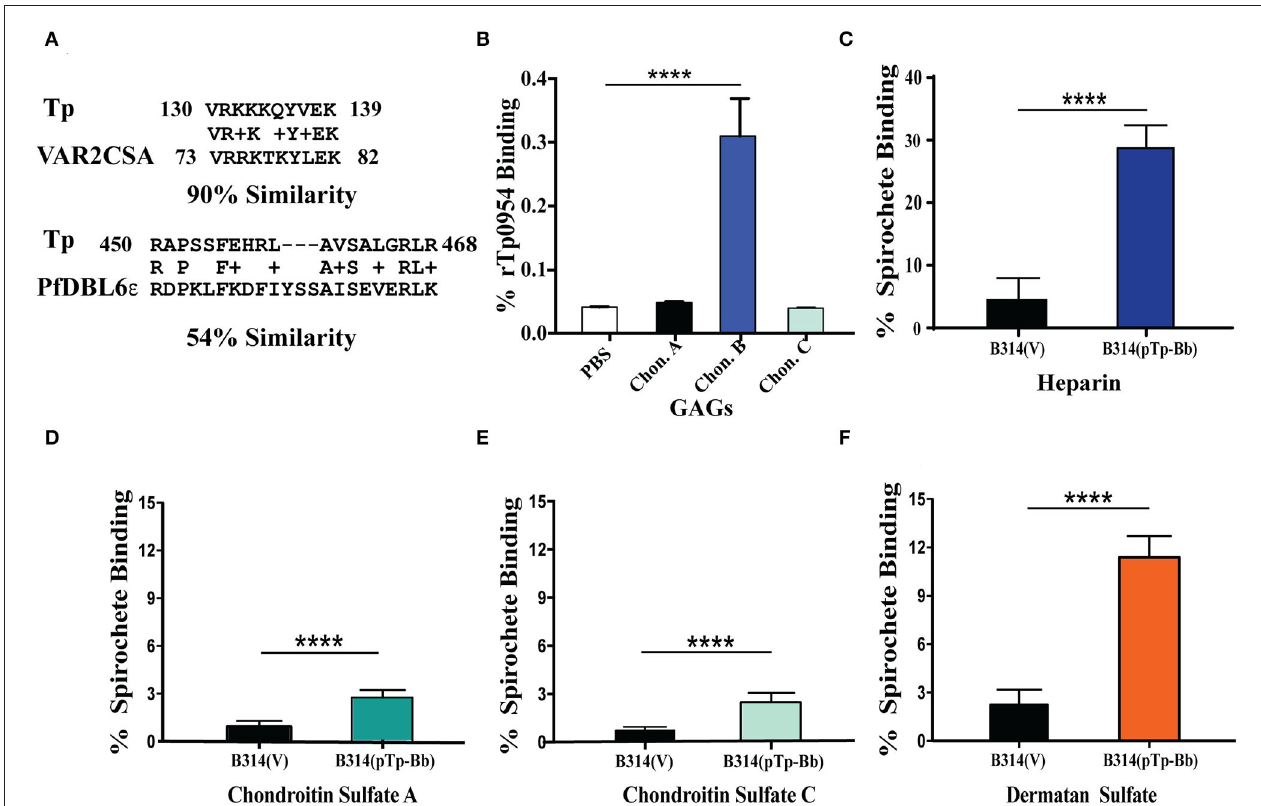
FIGURE 3 | Tp0954 mediated binding to purified GAGs. (A) Homology of Tp0954 epitopes with VAR2CSA domains of P. falciparum PfEMP1 protein. (B) Recombinant Tp0954 protein bound at significantly higher levels to dermatan sulfate than other chondroitin sulfates. (C) Binding to heparin, the most negatively charged biological molecule, enhanced in the most pronounced manner on expression of Tp0954 in B314 strain. Tp0954-expressing B314 binding increased minimally to empty wells (PBS) used as negative control (not shown). (D–F) Binding of B314(pTp-Bb) increased in the most pronounced manner compared to control B314(V) strain to dermatan sulfate (chondroitin sulfate B) among three types of chondroitin sulfates examined. Statistically significant difference was determined by unpaired two-tailed t -test with Welch’s correction (**** P <